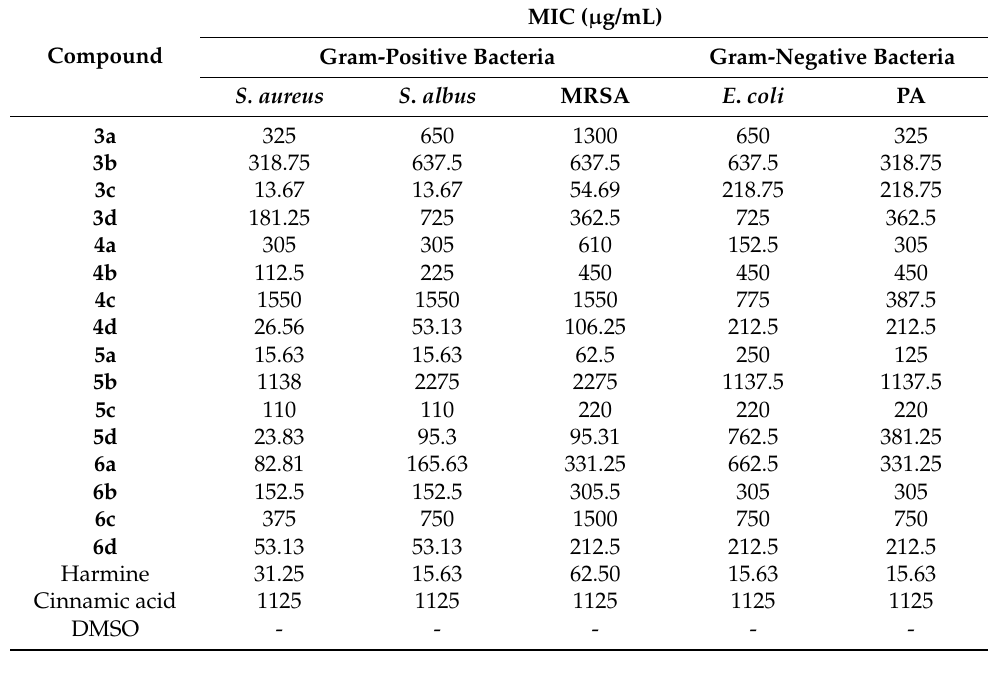
Table 1. Minimum inhibitory concentration of the synthesized harmine derivatives.